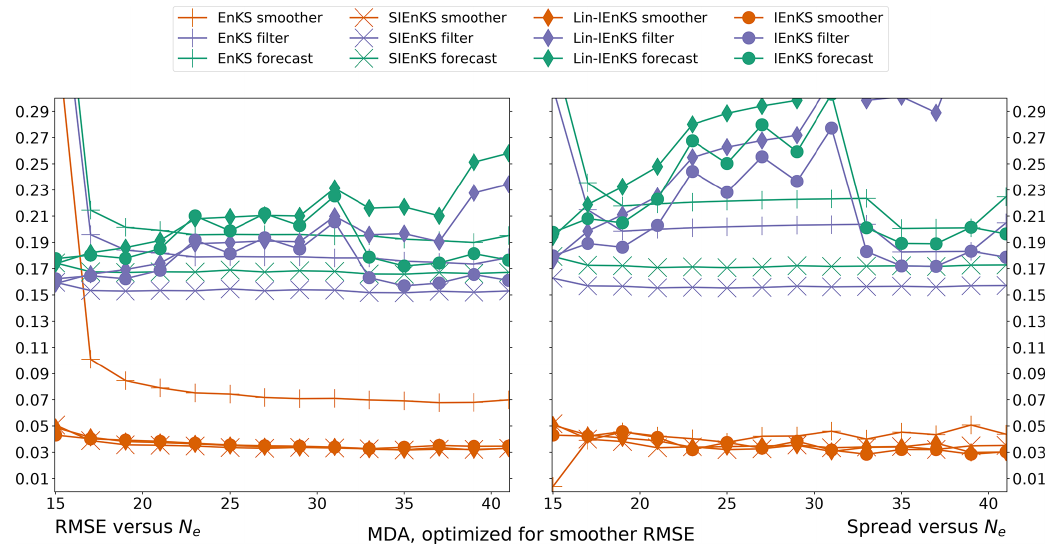
Figure 13. MDA configuration. RMSE and spread versus the ensemble size N e . Lag and inflation are optimized for a minimum forecast RMSE in Fig.